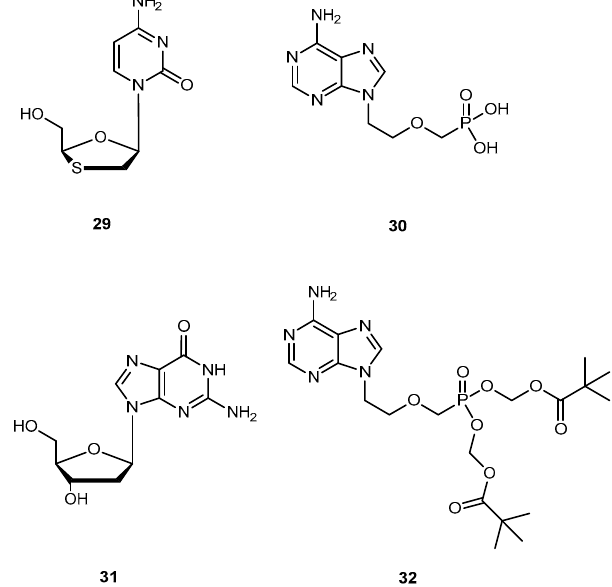
Figure 14. Chemical structures of drugs, lamivudine ( 29 ), adefovir ( 30 ), entecavir ( 31 ) and PMEA ( 32 ), used against chronic infection of hepatitis B virus.